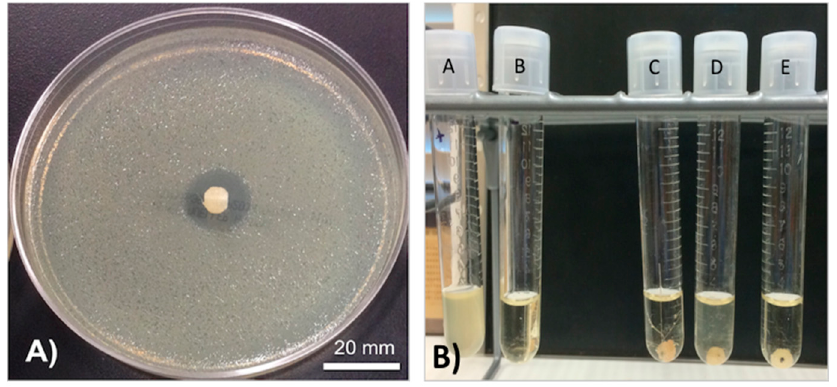
Figure 6. ( A ): 7.5 wt % GS-loaded HNT-PLA 3D-fabricated bead; ( B ): (A) = E. coli inoculated broth, (B) = sterile broth; (C–E) = 7.5 wt % GS-loaded HNT-PLA fabricated bead.